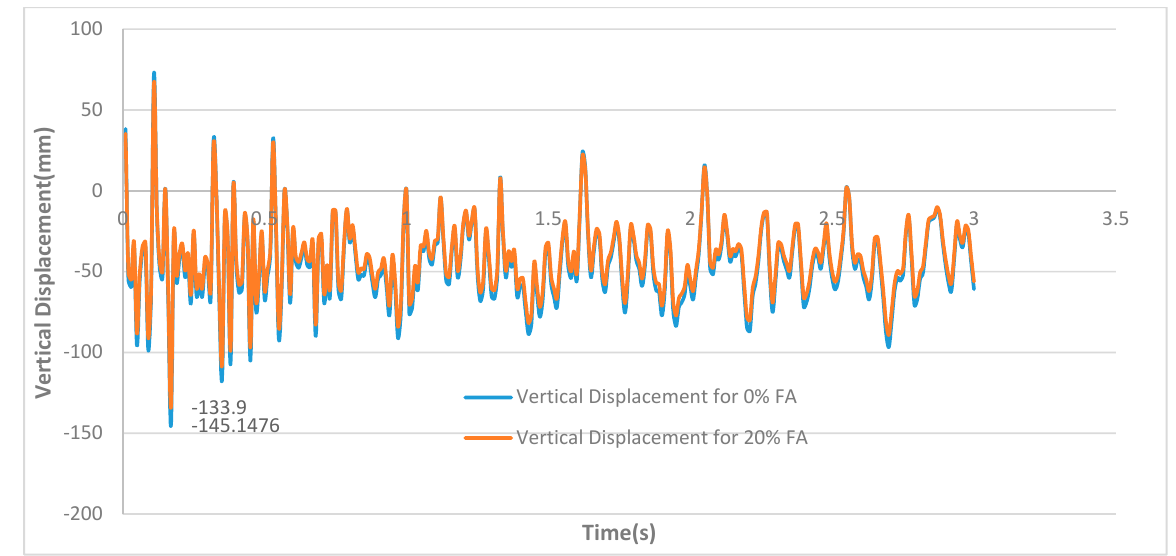
Figure 25. Comparison of time-history curves for vertical displacement of the pipe crown with the inclusion of 20% and 0% FA due to the Tabas earthquake.